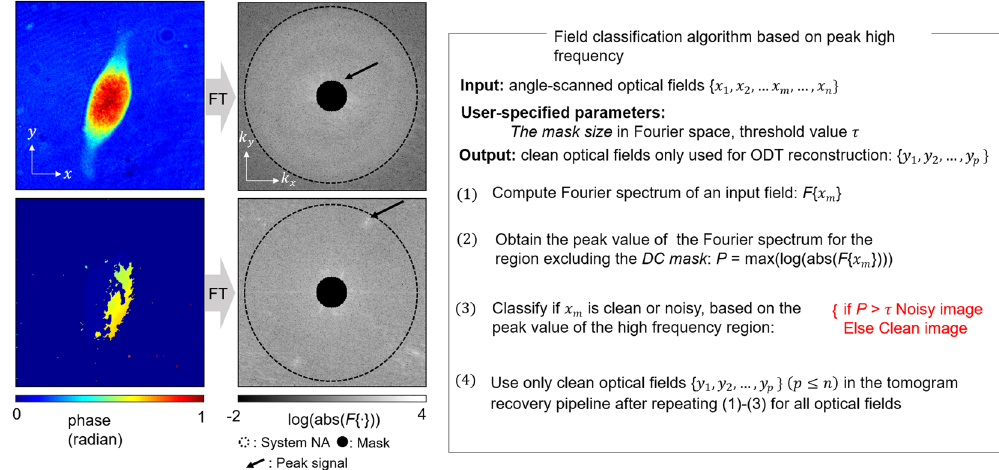
Figure 3. Rule-based algorithm for classifying optical fields. (Left) clean and noisy NIH3T3 phase images and their Fourier spectrum. (Right) flowchart/procedure of the algorithm that computes the peak value of the high- frequency region for each optical